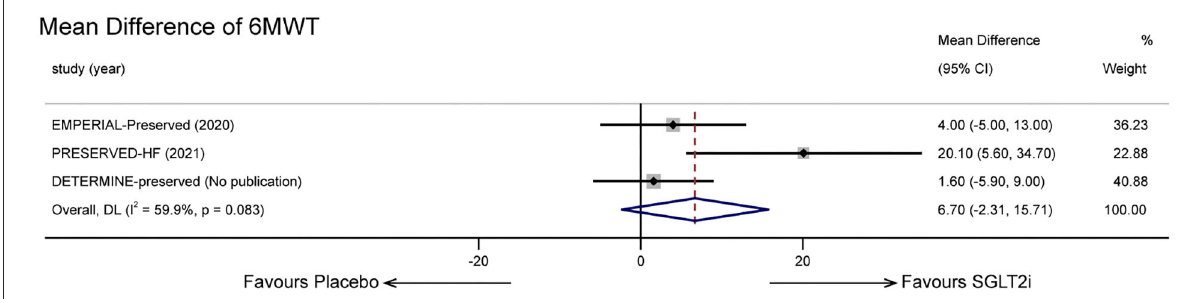
FIGURE5 Effect of SGLT-2 inhibitors vs. placebo on 6-Minute Walking Test.